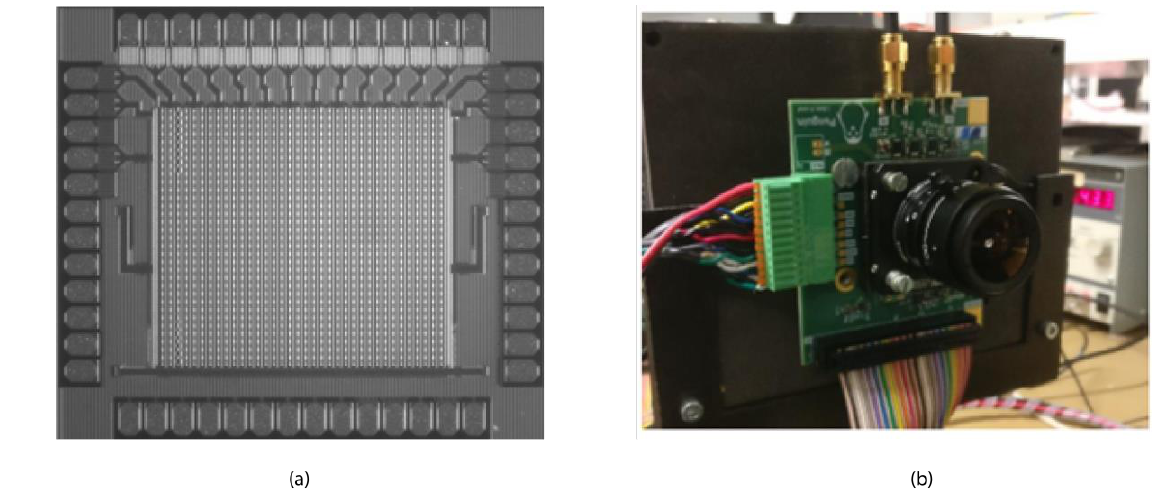
Figure 17. Micrograph of the 32 × 32-pixel CAPS array ( a ) and camera setup ( b ).